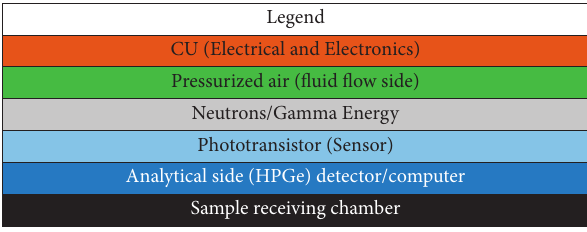
Figure 4: Legend of Figures